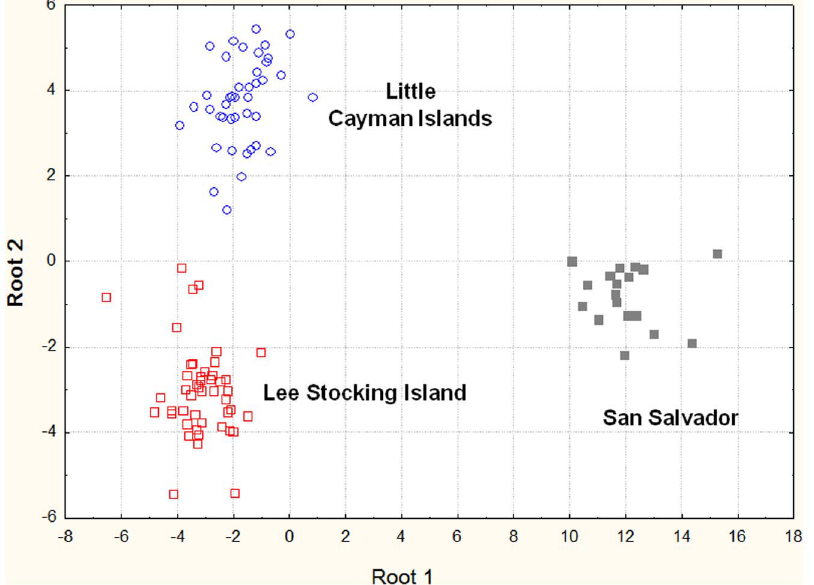
Figure 1. Plot of standardized coefficients for canonical variables based upon discriminant function analysis of samples classified only by collection sites. Little Cayman Island –open circles, San Salvador – closed squares, Lee Stocking Island – open